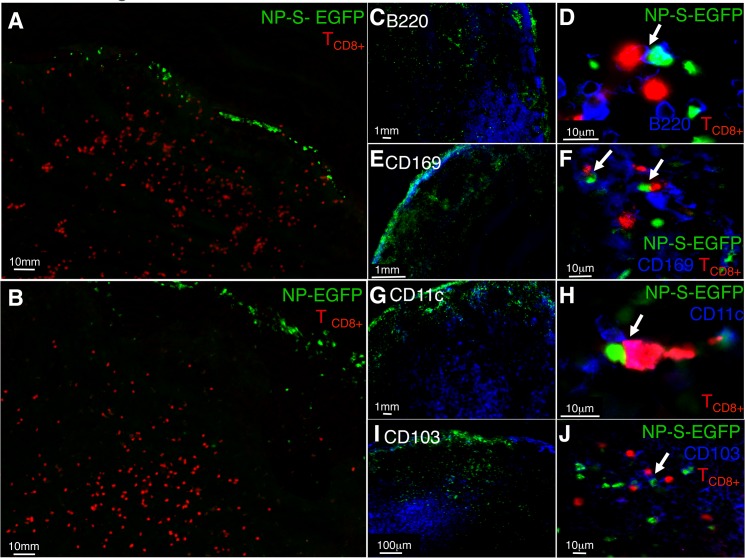
Antigen specific T cells relocate to the LN periphery where they interact with infected pAPC expressing antigen in vivo.(A and B) Localization of OT-I TCD8+ following ECTV infection. Naïve OT-I TCD8+ were labeled with cell tracker CMTMR dye (red) and adoptively transferred. Mice were injected with NP-S-EGFP or NP-EGFP i.d., and 12 h.p.i., D-LN were harvested and analyzed by fluorescence microscopy. (C, E, G, I) Mice were injected with NP-S-EGFP or NP-EGFP i.d., and 24 h.p.i. D-LN were harvested and stained for B220+ B cells, CD169+ macrophages, CD11c+ DC and CD103+ DC, and analyzed by fluorescence microscopy. (D, F, H, J) High power view of interaction of naïve OT-I TCD8+ and ECTV-infected pAPC. The insets (D, F, H, and J) show 2-dimensional projections of one plane of the 3-dimensional datasets. Each image is representative of 3 experiments, with a minimum of 4 infected nodes per experiment.